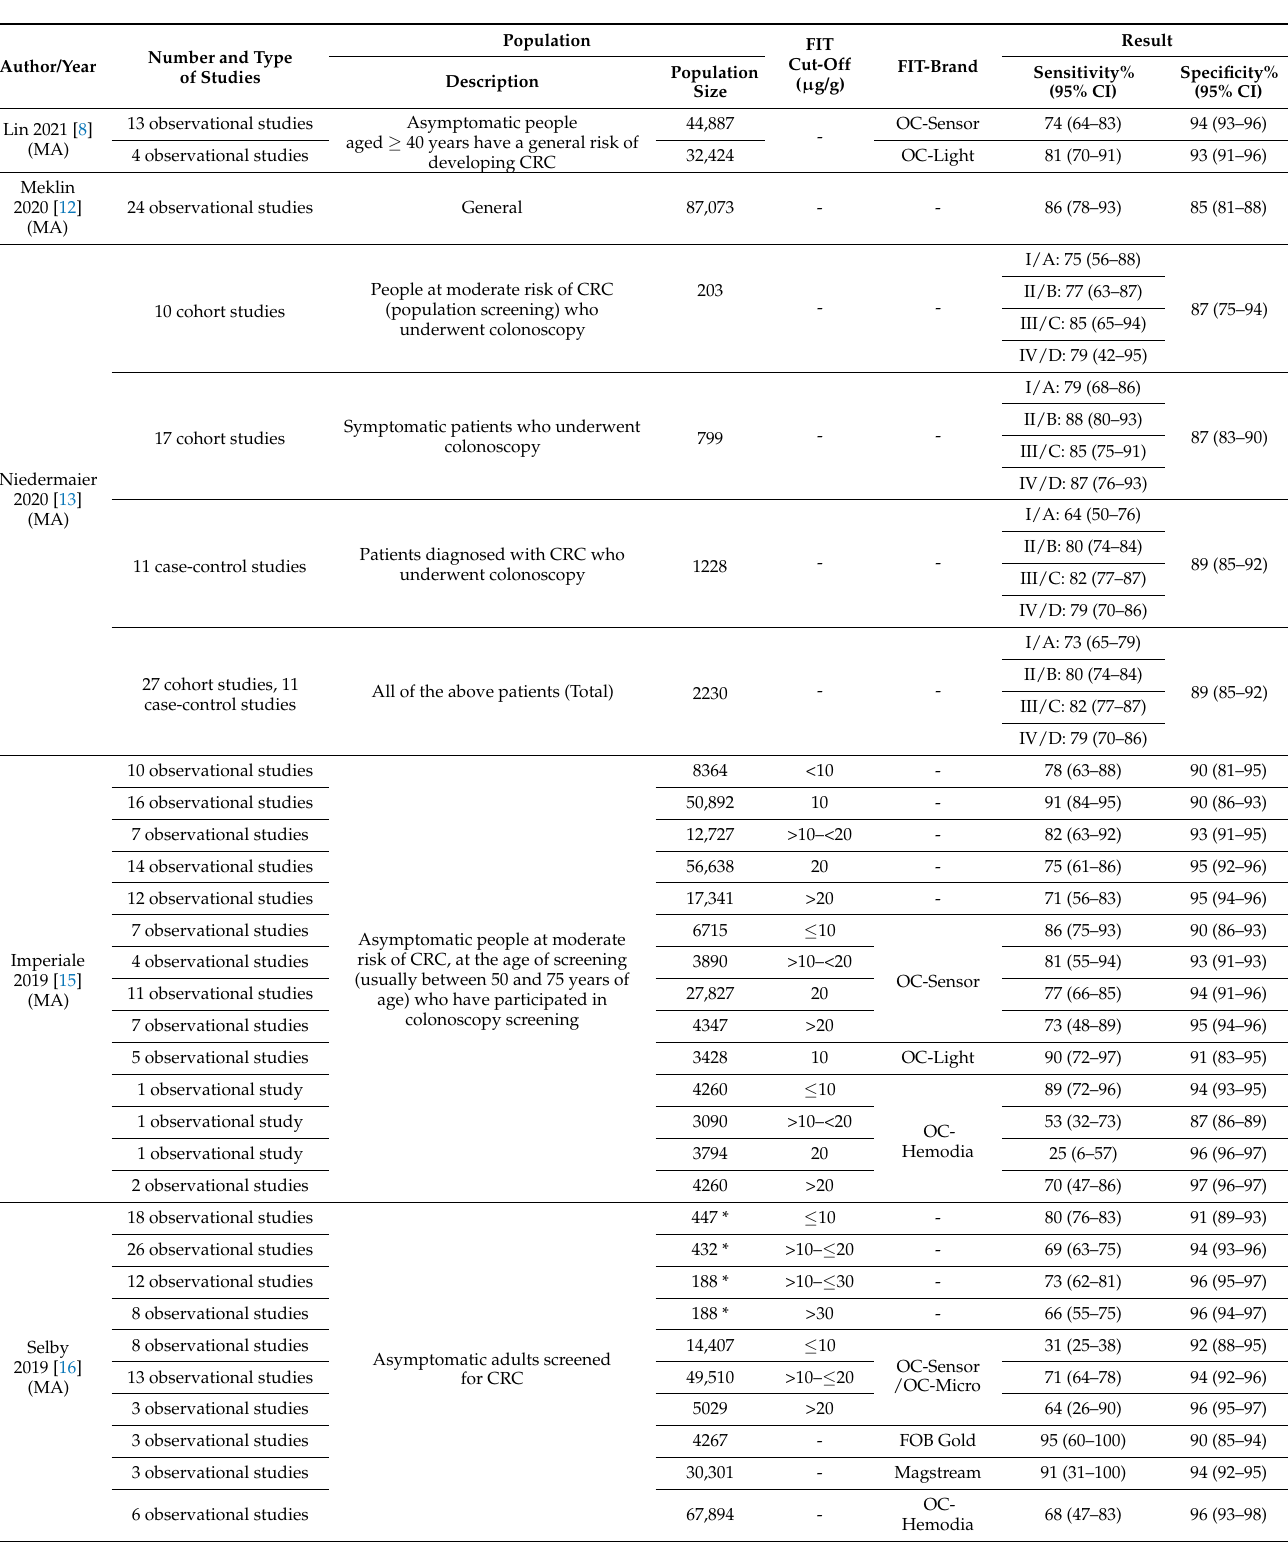
Table 1. Characteristics and results of tests in regard to the diagnostic precision of FIT in the detection of